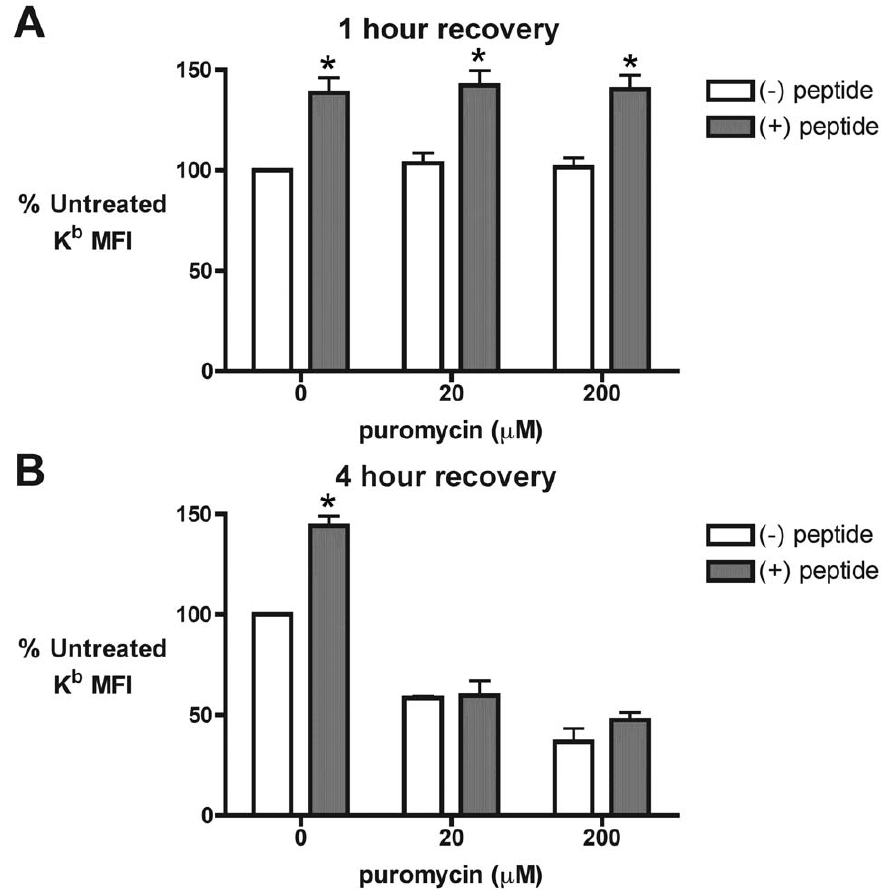
Figure 7. Time-dependent inhibition of MHC class I pathway function following puromycin treatment. A and B. 293-K b cells were stripped of cell surface MHC I peptides as in Fig. 5. Recovery of cell surface K b was conducted in the presence of varying concentrations of puro for one ( A ) and four ( B ) hours. During the final 30 minutes of the recovery, cells were treated with either distilled water (( 2 ) peptide) or 5 m M SIINFEKL peptide (( + ) peptide) to promote the export of K b to the cell surface [31]. Flow cytometry was used to measure total cell surface K b and the MFI was normalized to untreated cells in the absence of exogenous SIINFEKL peptide ( n =3; mean 6 s.e.m.; * p , 0.05 for ( 2 ) peptide vs. ( + ) peptide).